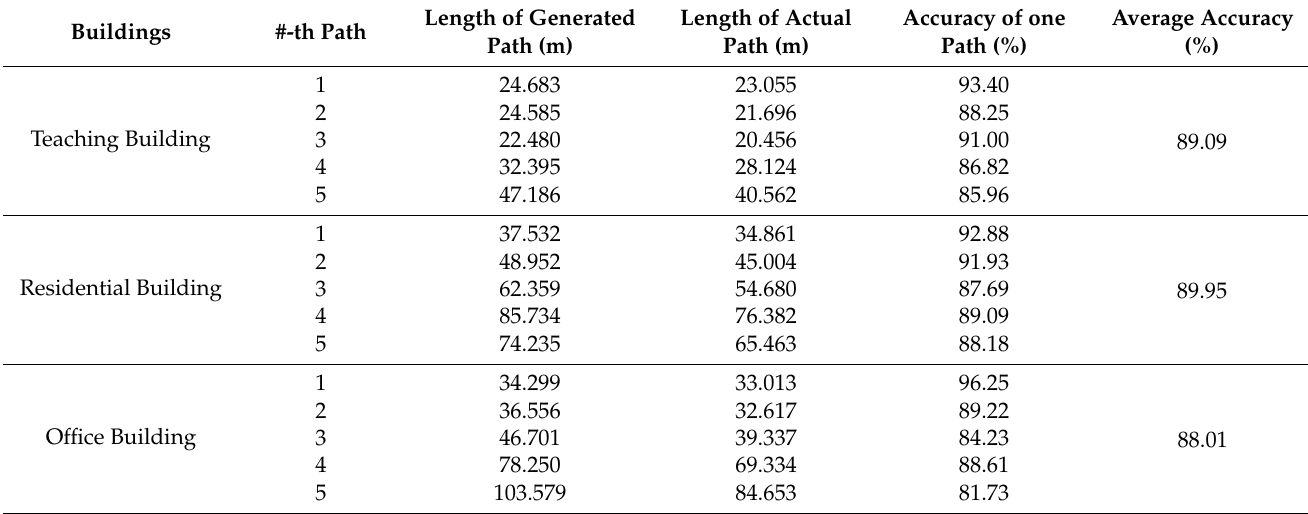
Table 2. Accuracy of the experiment